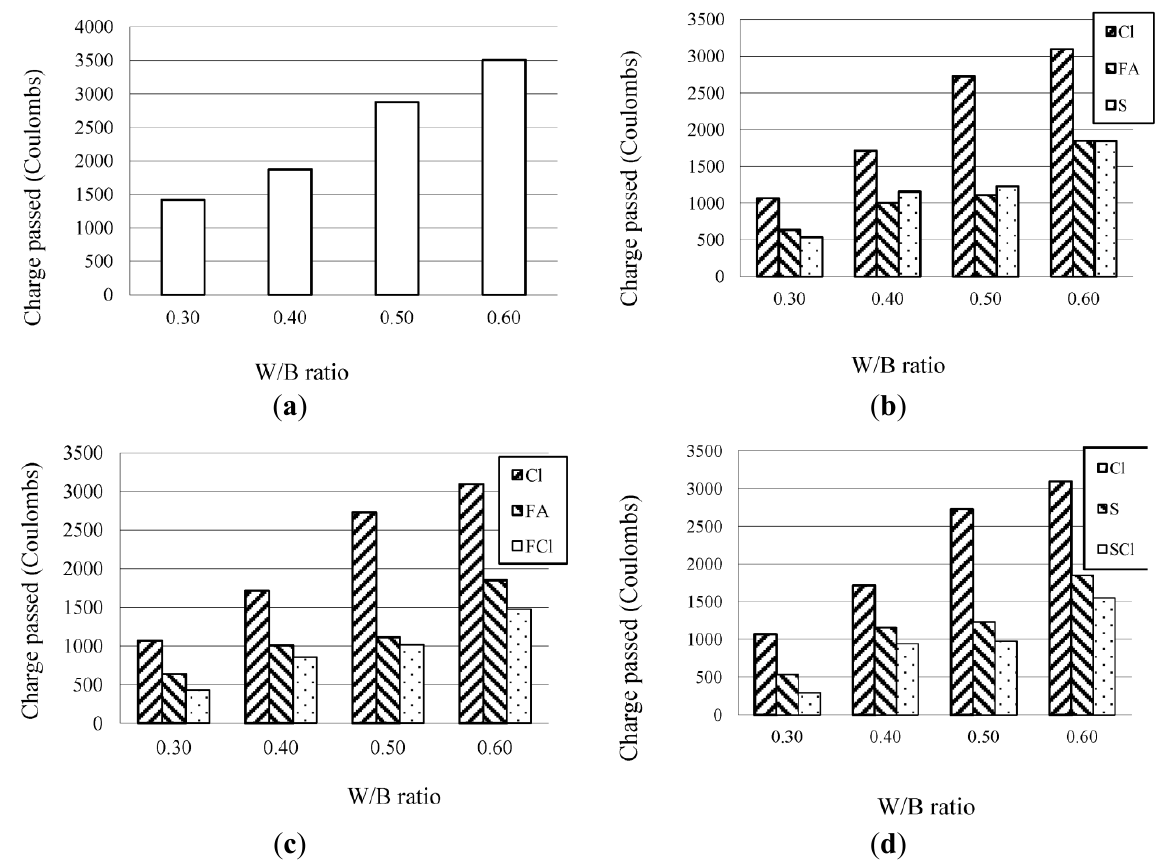
Figure 1. Results of chloride ion penetration through concrete. ( a ) Charge passed of control concrete; ( b ) Charge passed of concrete with one type of mineral admixture; ( c ) Charge passed of concrete with the Cl agent and fly ash; ( d ) Charge passed of concrete with the Cl agent and